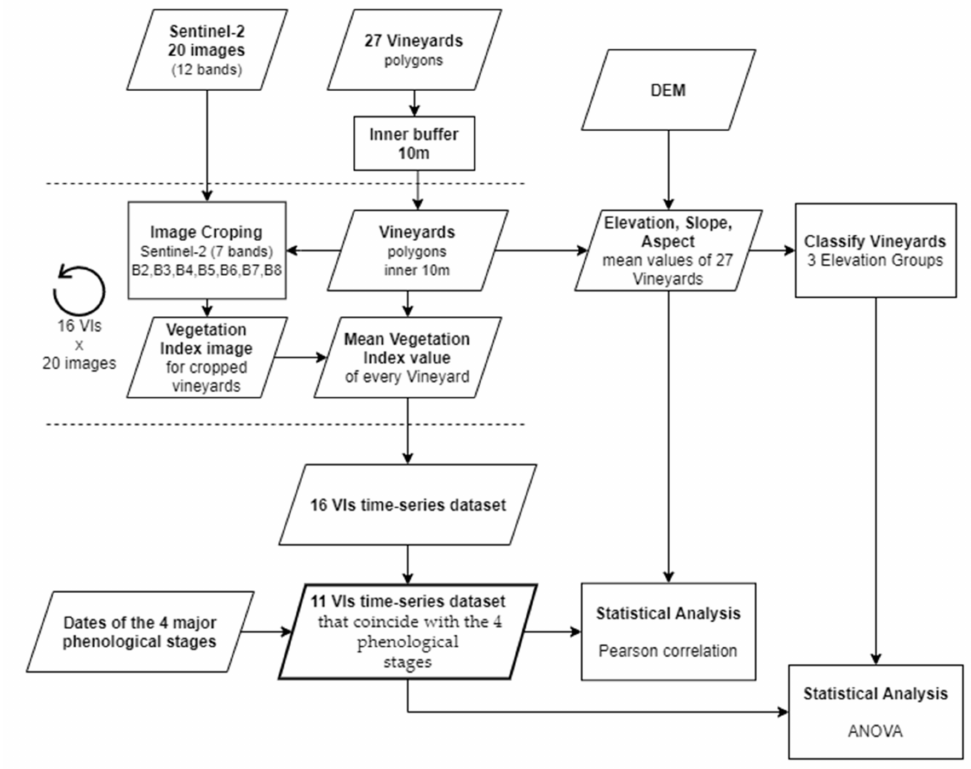
Figure 4. Data processing and analysis flow